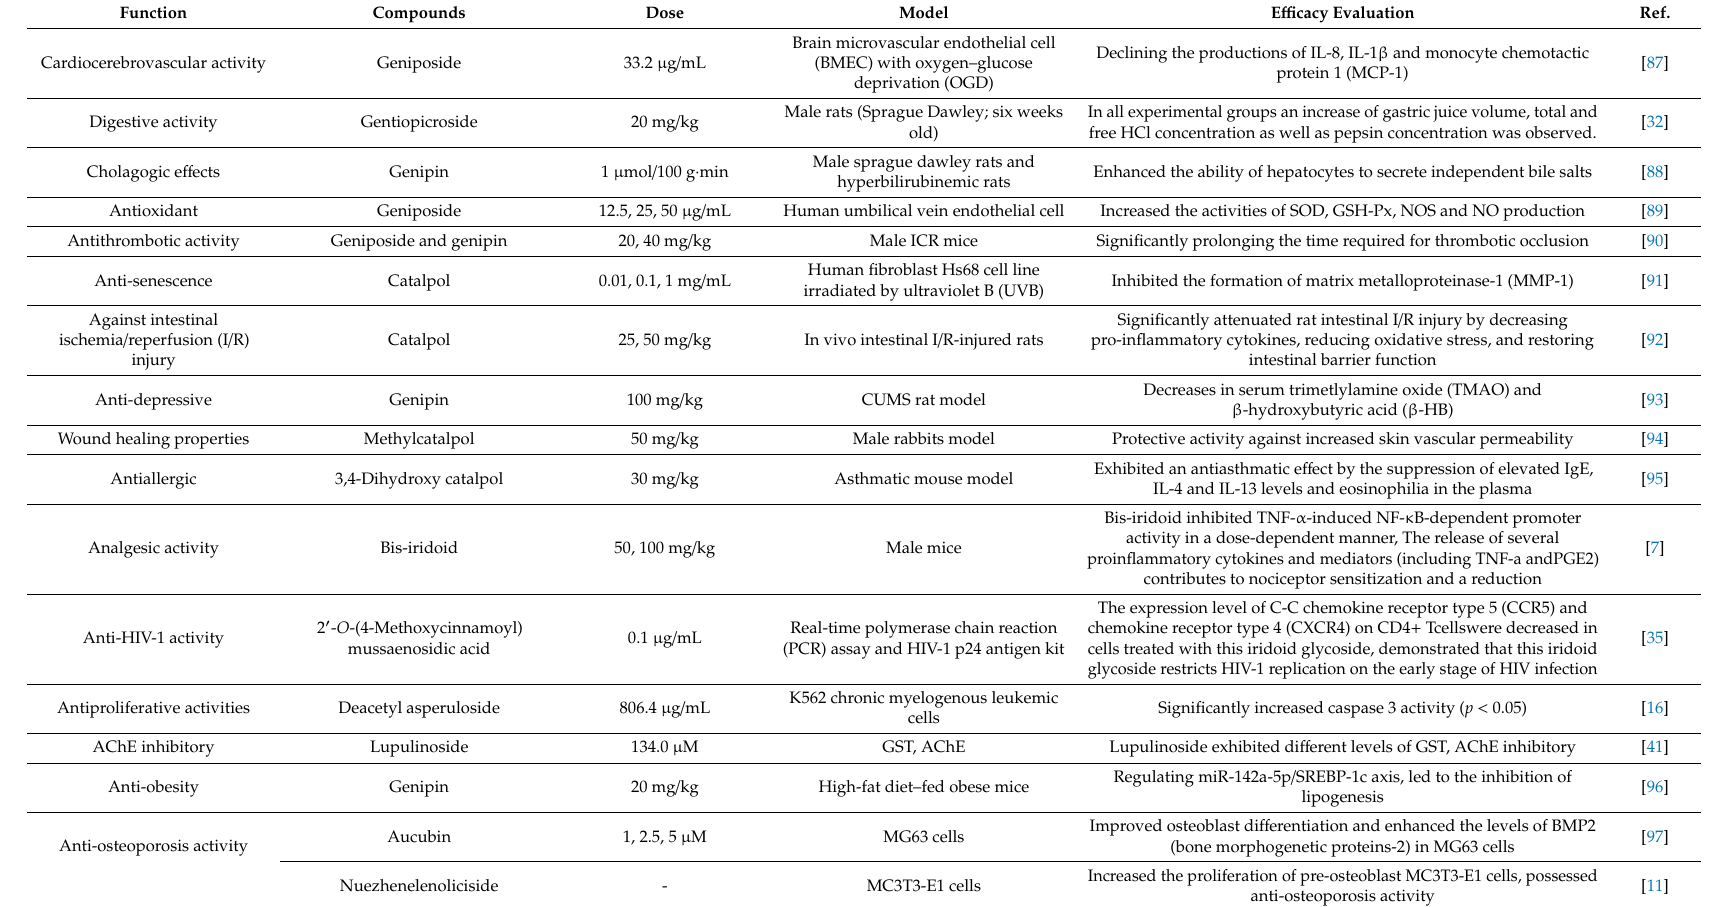
Table 2. Other activities of